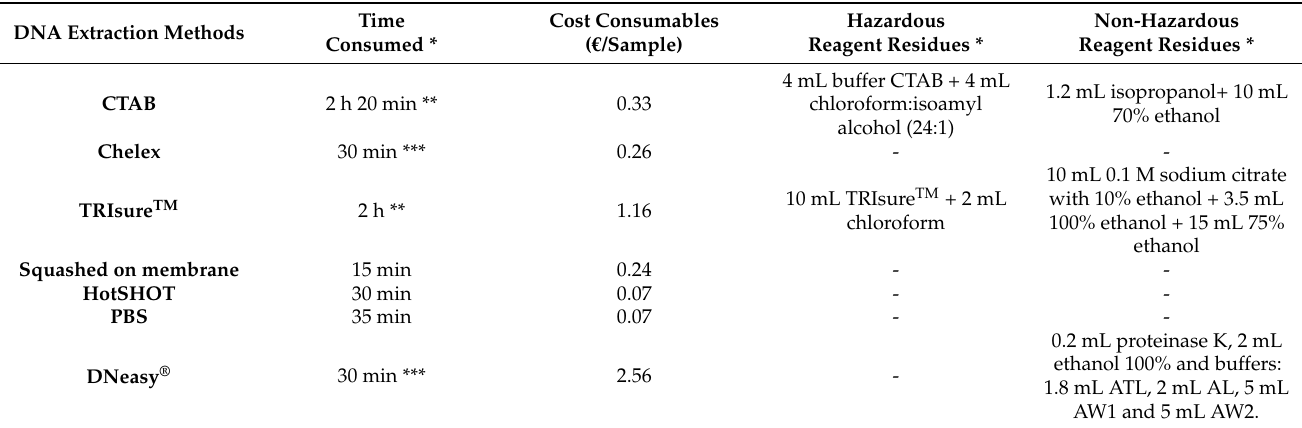
Table 8. Summary of protocol according of time consumed, cost per sample, and reagent residues generated for each of the evaluated DNA extraction method.